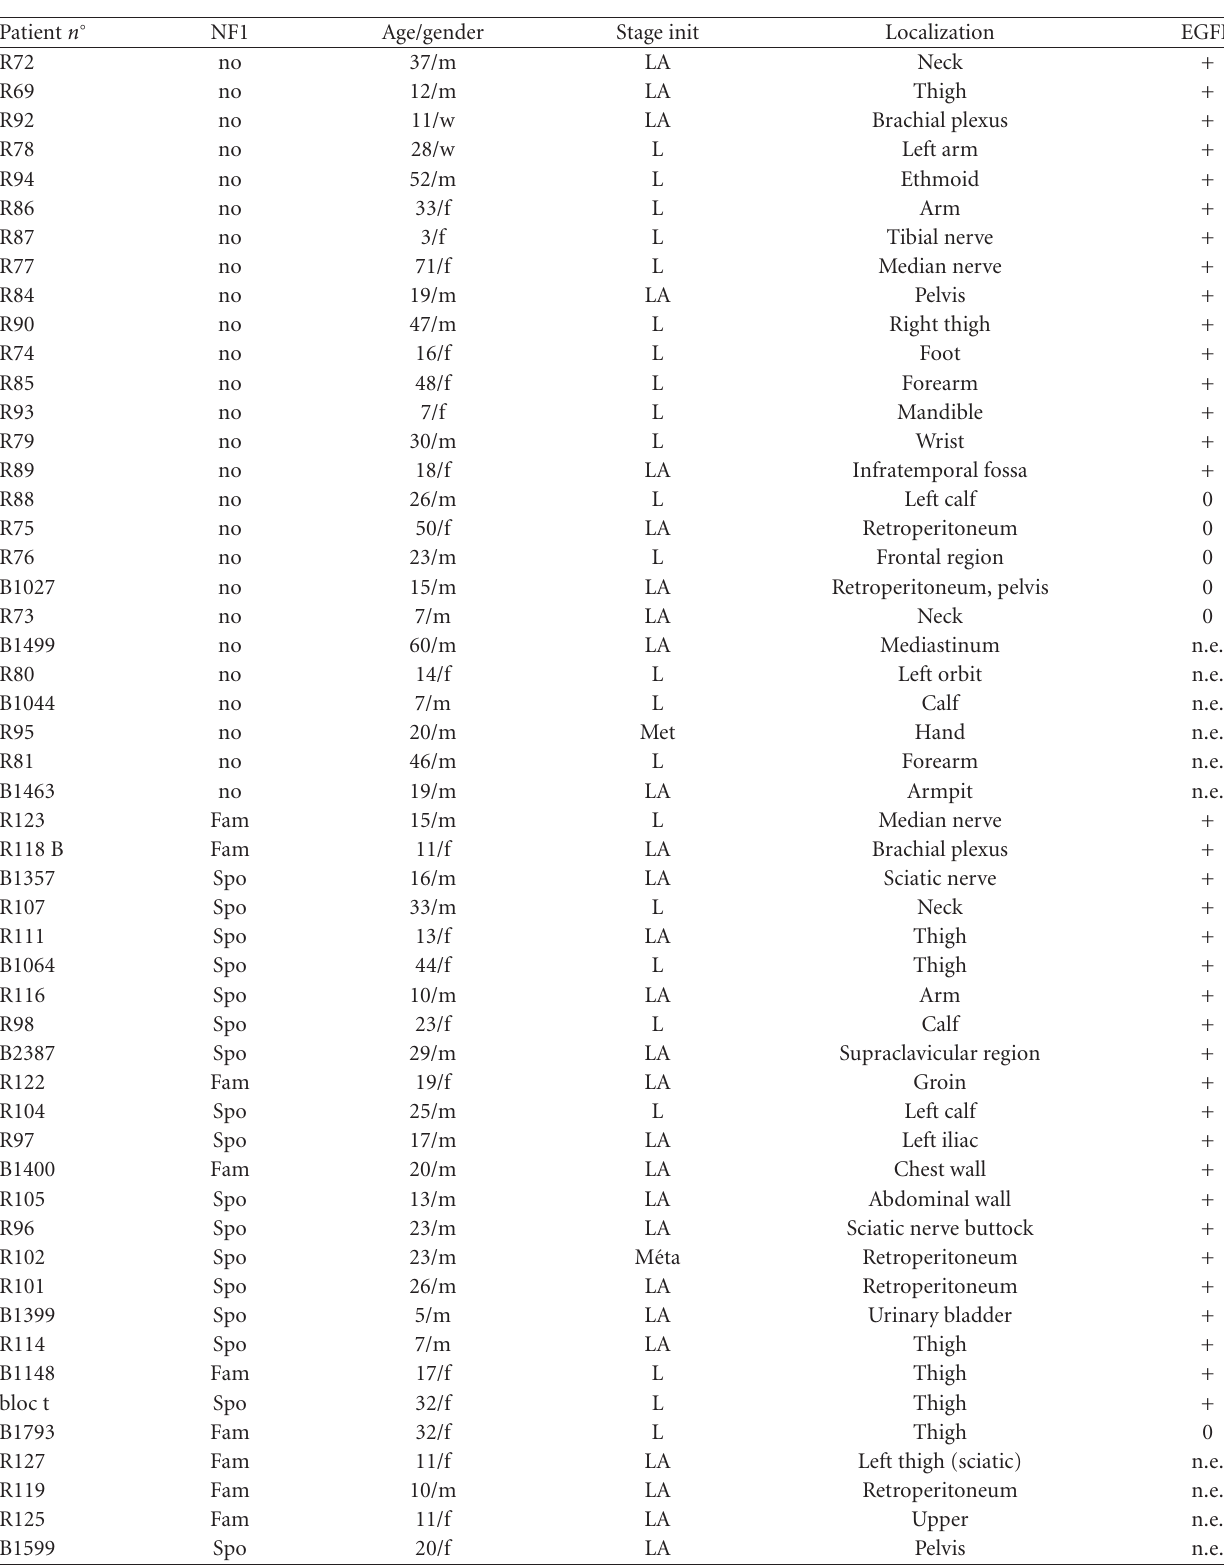
Table 1: Characteristics of the 52 patients with MPNST . NF1: Neurofibromatosis type 1; Spo: sporadic form of NF1 (no familial history), Fam: familial form of NF1; L: local stage; LA: locally advanced stage; Met: metastatic stage. A: alive. D: dead; +: positive staining; − : negative staining; n.e.: not evaluable